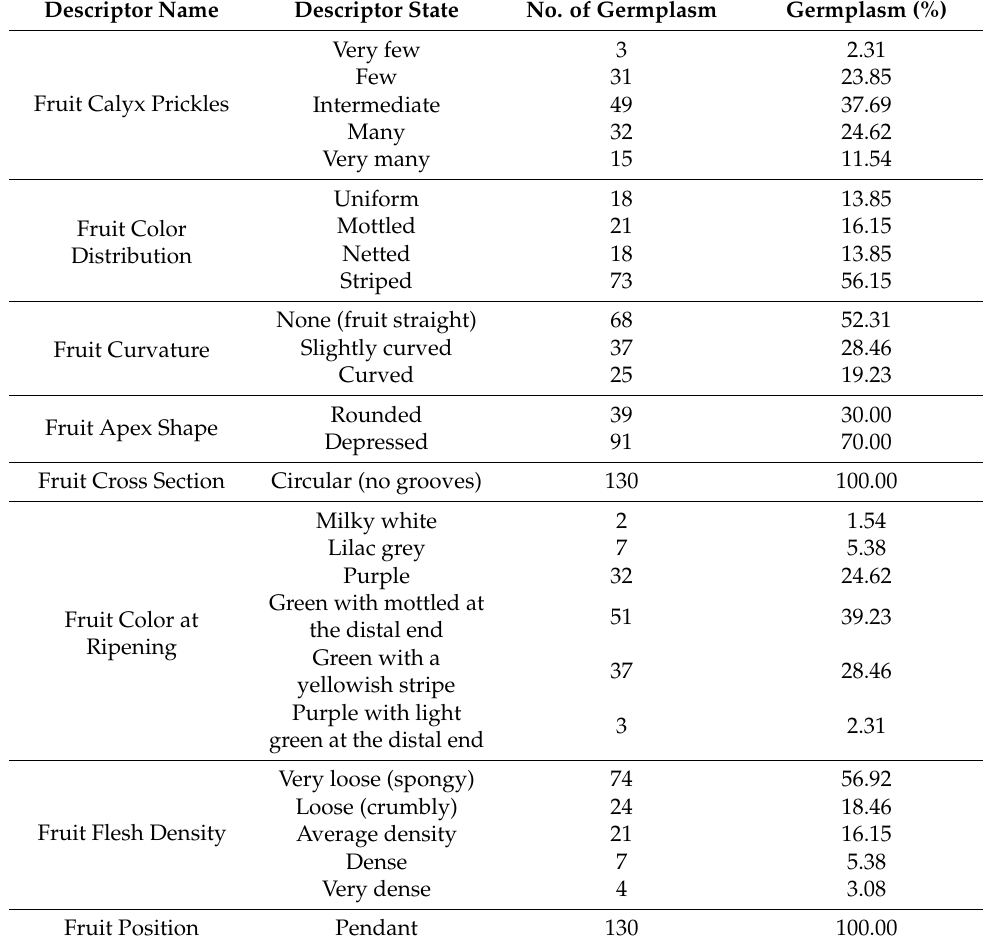
Table 3. Variability in fruit traits in eggplant